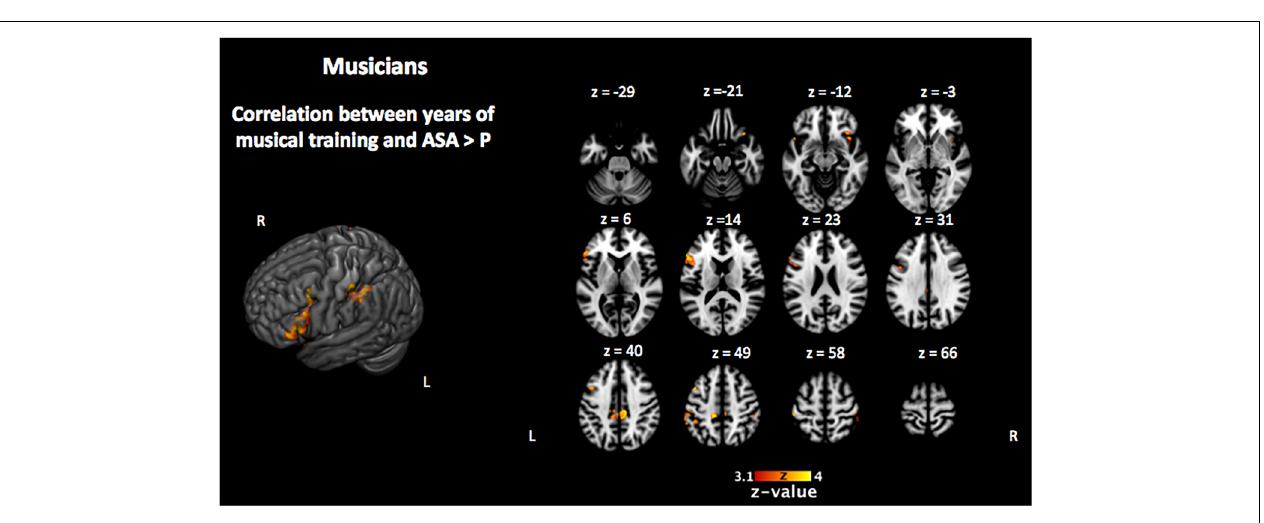
FIGURE 6 | Activation that correlated with the years of musical training in the musically trained group during the encoding phase of the [ASA > P] contrast (corrected p < 0.05). ASA, auditory selective attention; P,